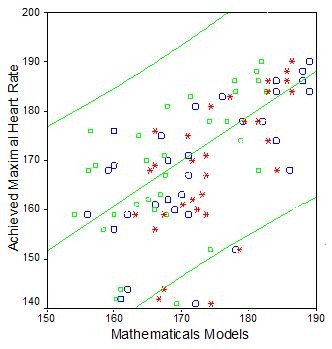
Correlation between age-predicted HRMax versus the achieved HRMax values. large circles = 220 - age, small squares = Fibromyalgia Model CI 95%, stars = 208 - 0.7 × age. HRMax = maximum heart rate, CI = confidence interval. The circles and squares are inside confidence interval (CI) of fibromyalgia syndrome formula (Fibromyalgia Model HRMax = 209 - 0.85 × age).